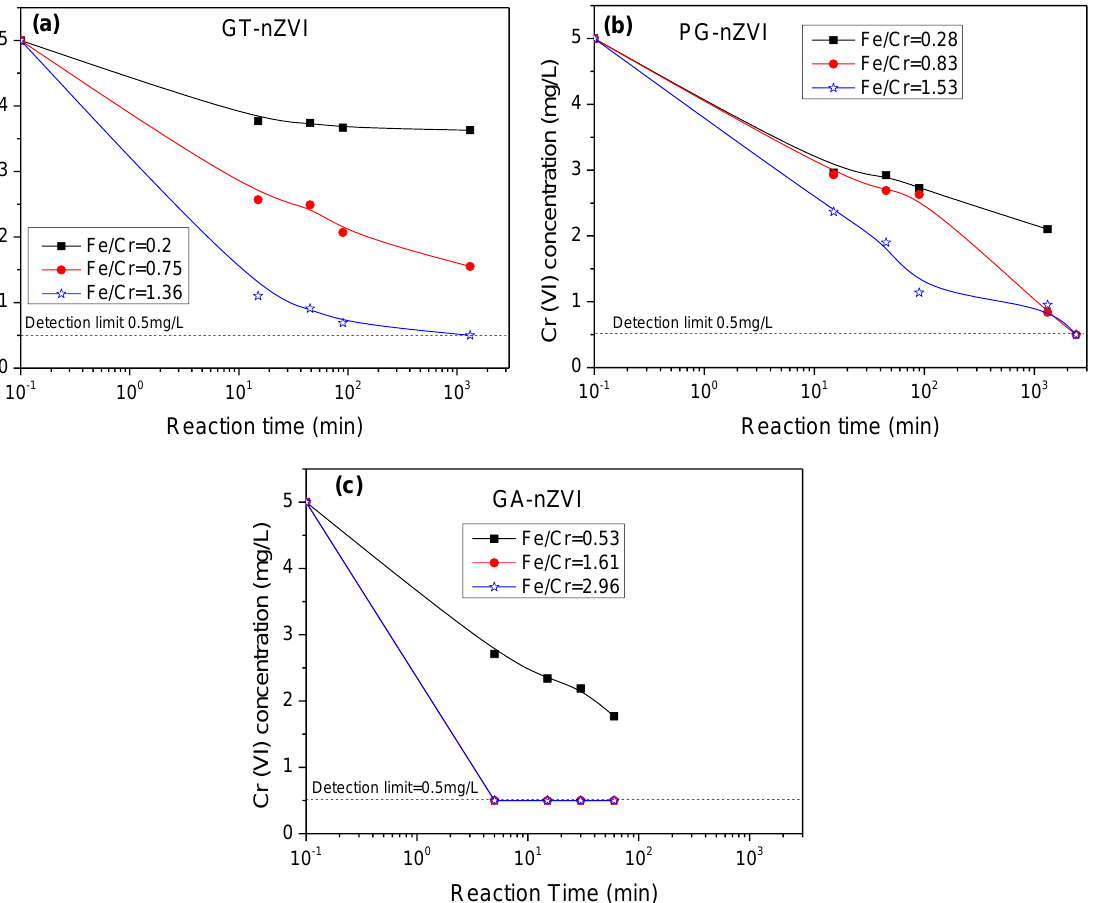
Figure 8. Kinetics of the hexavalent chromium reduction by (a) GT-nZVI, (b) PG-nZVI (c)